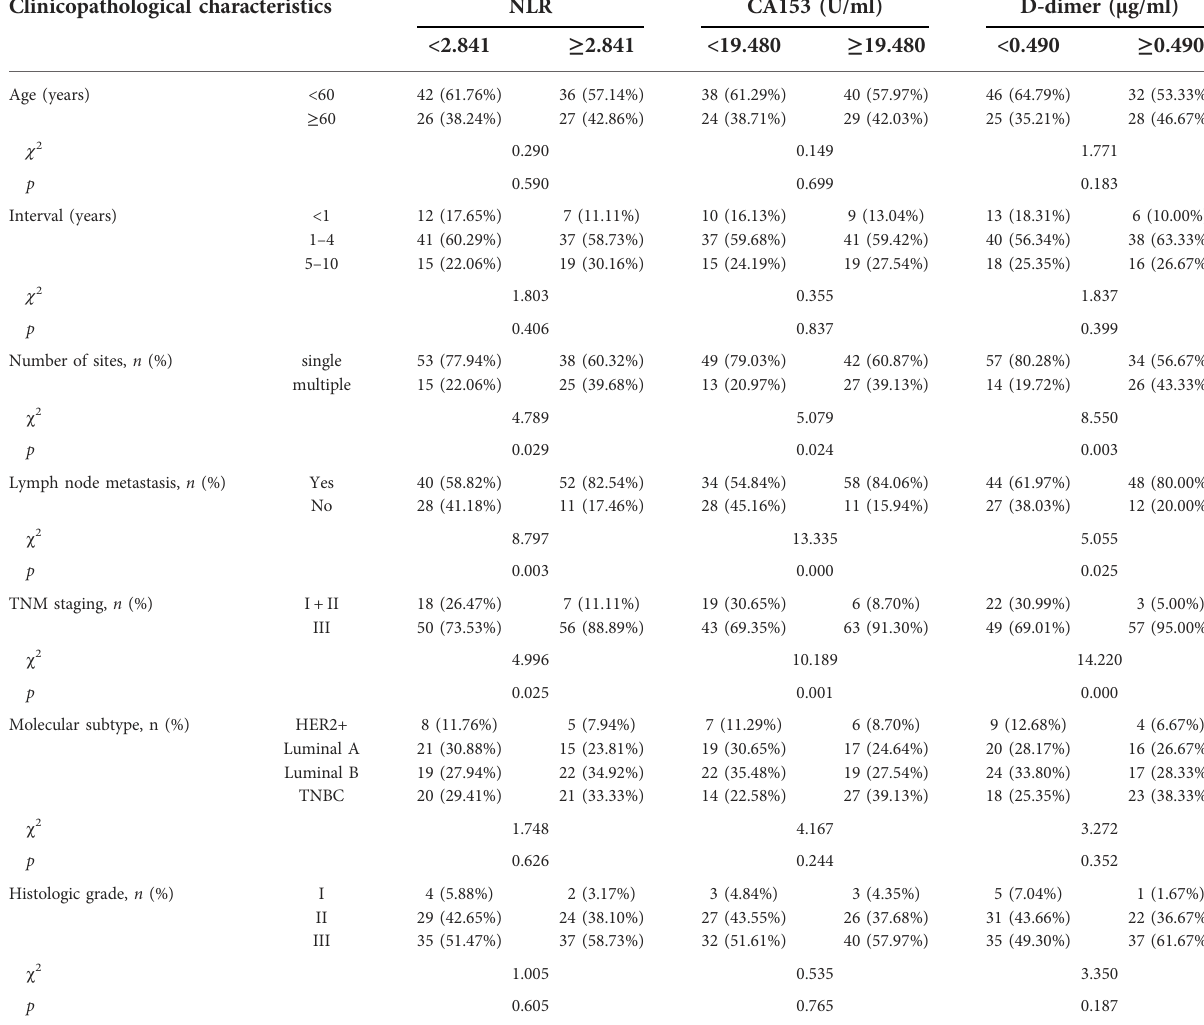
TABLE 7 Relationship between NLR, CA153, D-dimer, and clinicopathological characteristics of the recurrent and metastatic group. Clinicopathological